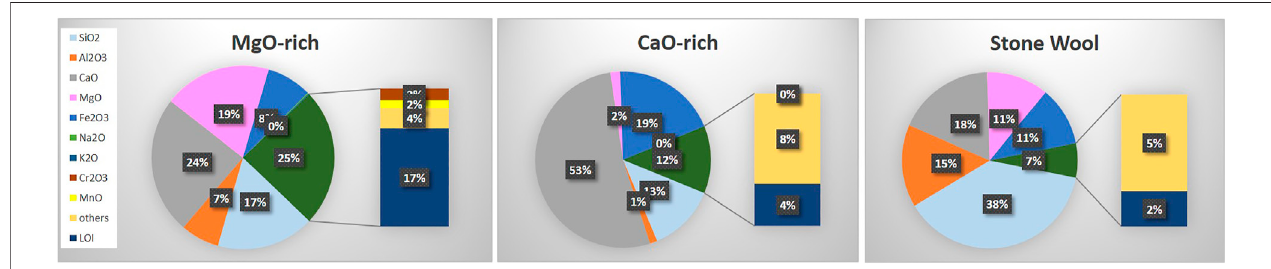
FIGURE1| Comparison oftheoverallchemicalcomposition(oxideswt%) oftheslagsmixturesand thestonewool.Thesearethealuminosilicatesourcesused for the preparation of the alkali activated materials (Other (cid:1) minor oxides, LOI (cid:1) loss on ignition at 950 °